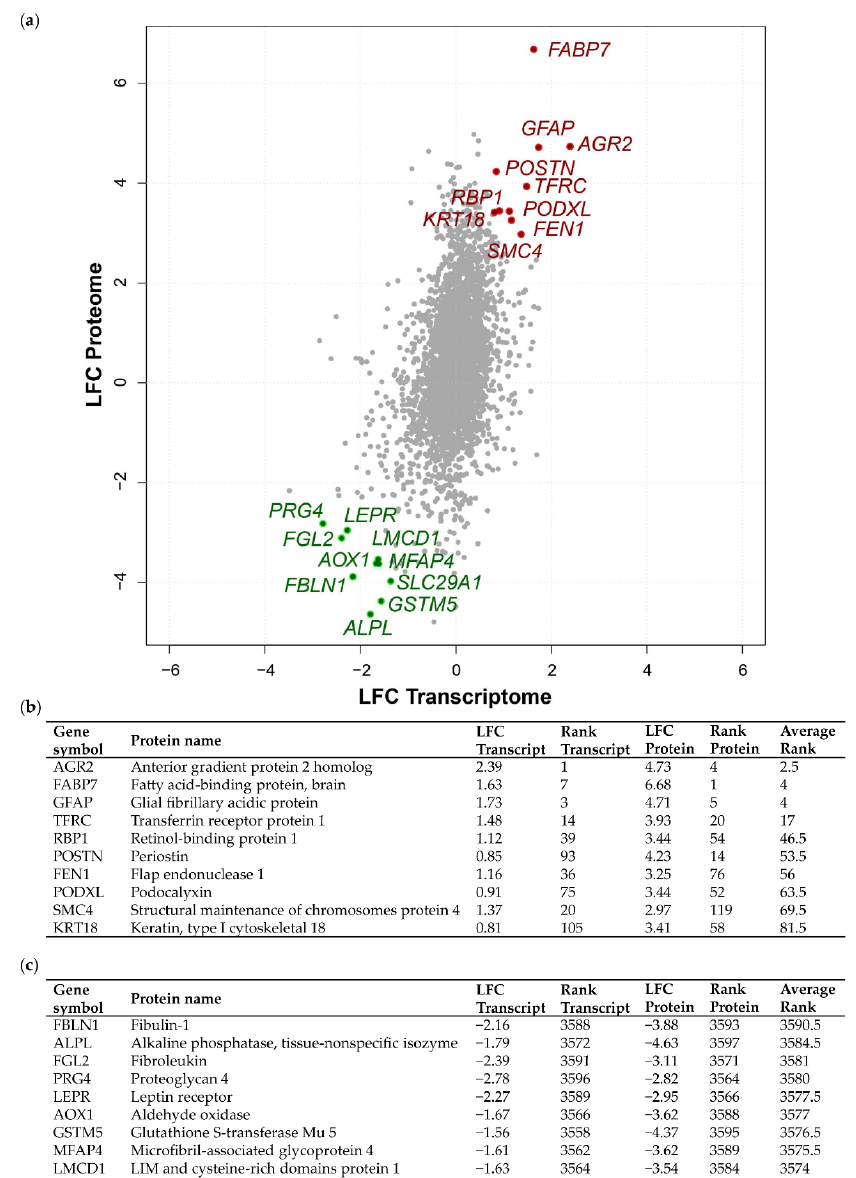
Figure 1. Concordant transcriptome–proteome di ff erential expression of grade III vs. grade I meningiomas. ( a ) Scatterplot displaying 3598 genes commonly identified in a transcriptomic microarray analysis including 13 non-recurrent grade I meningiomas and 20 malignant grade III meningiomas and a global proteomic analysis including eight grade I and six grade III meningiomas [12,19]. Pearson’s correlation coe ffi cient revealed a modest, yet highly significant correlation of r = 0.35, p = 3.6 × 10 − 104 . Log 2 fold changes (LFC) at the transcript and protein level of overlapping genes are shown for grade III vs. grade I meningiomas. The top 10 genes based on average rank value exhibiting concordantly increased or decreased LFC between the two datasets are highlighted in red or green, respectively. ( b , c ) Top 10 genes showing concordantly increased ( b ) or decreased ( c ) LFC in grade III vs. grade I meningiomas are presented with respective LFC, rank and average rank values. Table S3A provides details of all 3598 genes common to both analyses, transcript / protein LFC, their rank and average